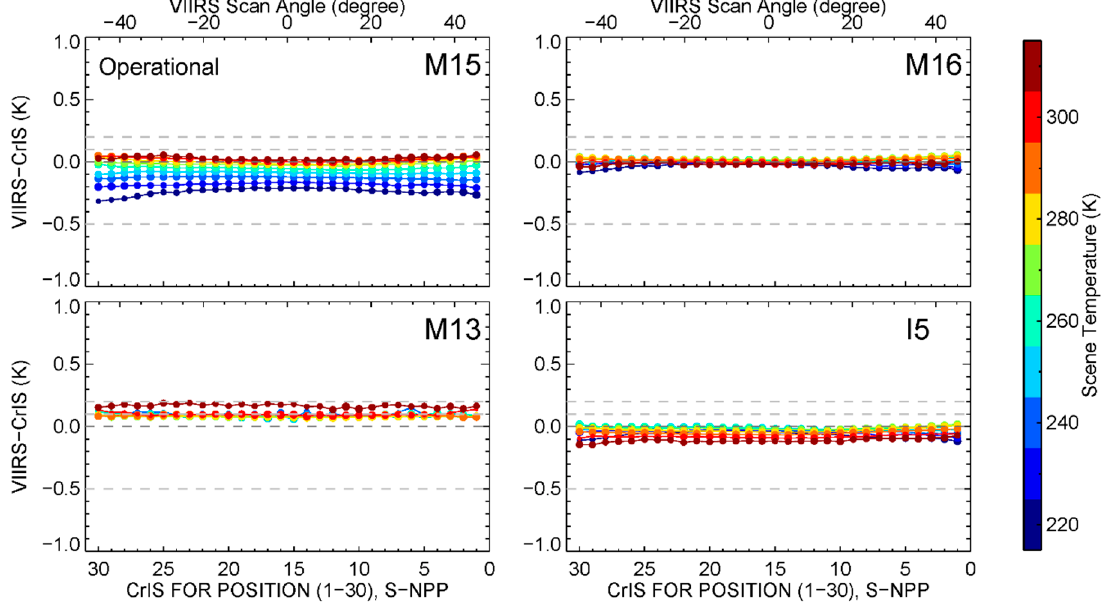
Figure 4. S-NPP VIIRS–CrIS BT differences at 10 scene temperatures and as function of CrIS FOR position and VIIRS scan angle. Under each scene temperature, the sizes of the filled circles are proportional to the number of data samples used.